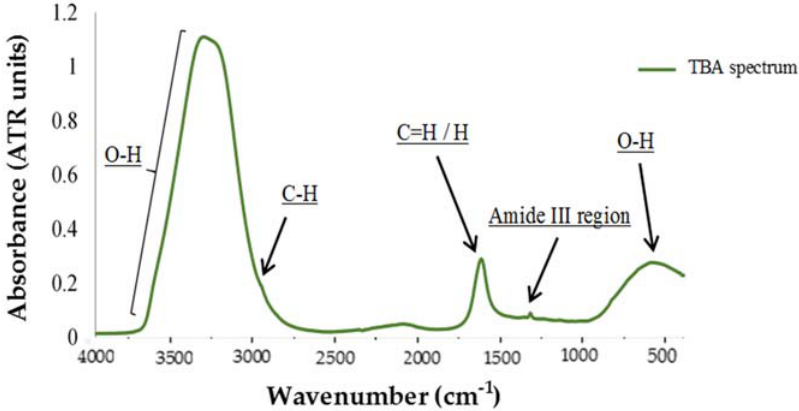
Figure 4. Example of MIR spectrum corresponding with L_OX (lipid oxidation) compounds.